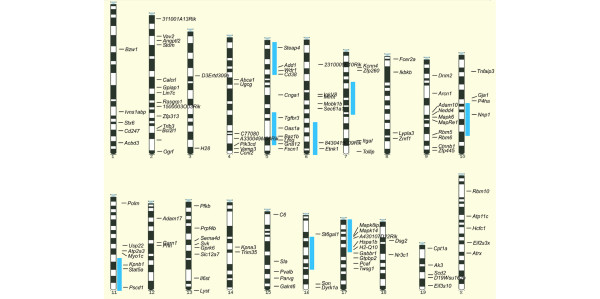
Visualisation of all the chromosomal locations of the small-effect QTL identified in this study (blue bar) as well as 120 genes of interest from gene expression profiling (black letters). The positions of the 120 genes and the peak markers of the QTL were retrieved from Ensembl [30]. Confidence intervals of all the QTL were set as 40 Mb.